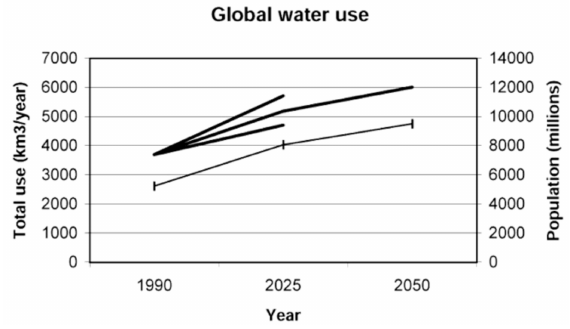
Figure 1. Global water resource use. Source: